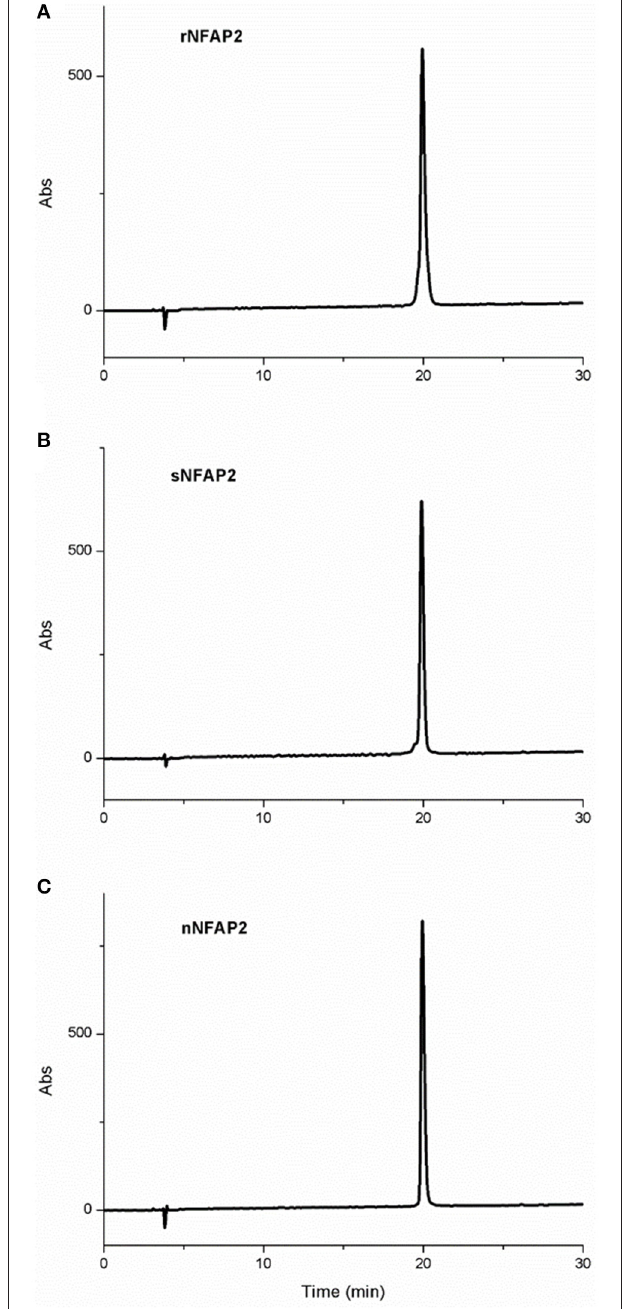
FIGURE 4 | RP-HPLC chromatogram of (A) rNFAP2, (B) sNFAP2, and (C) nNFAP2. A linear gradient was applied from 5 to 35% (v/v) solvent (B) in 30min. nNFAP2: native NFAP2 produced by N. fischeri NRRL 181, rNFAP2: recombinant NFAP2 produced by P. chrysogenum nfap2 , sNFAP2: synthetic NFAP2.